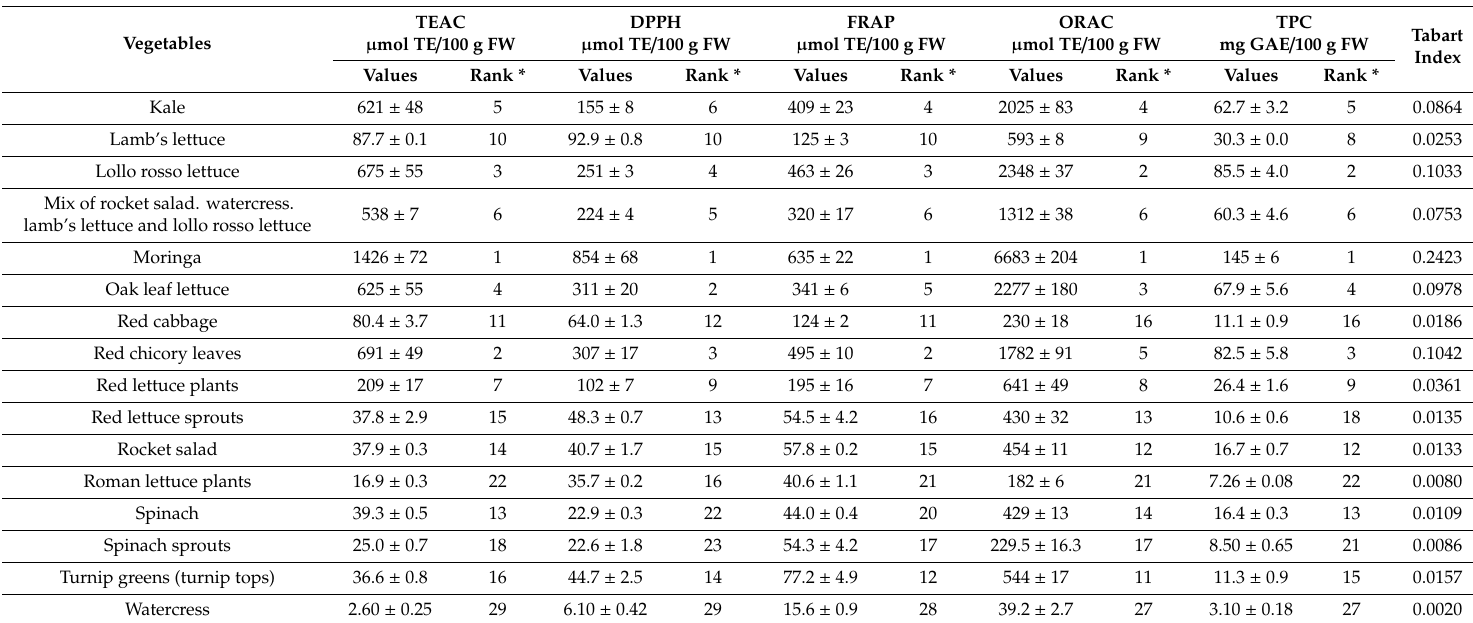
* Rank: The values obtained are ranked from highest (1) to lowest